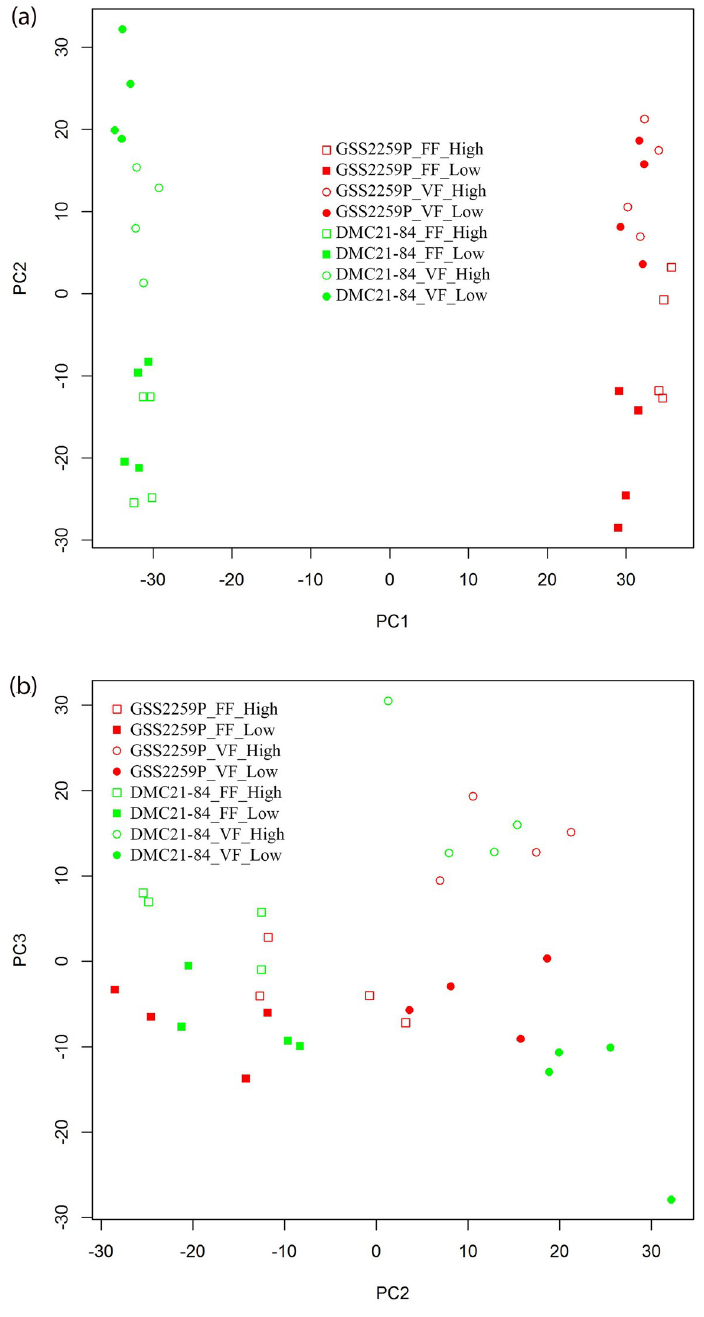
Fig 1. PCA plots with respect to a. PC1 and PC2, and b. PC2 and PC3. Treatments are identified by hybrid, site (FF = Fruit Farm; VF = Vegetable Farm), and plant density. homeostasis [48–51]. Due to the costly nitrogen requirement of HSP production, HSP produc- tion is poor under low nitrogen [52] or elevated CO [53]. A number of HSPs also were 2 involved in soybean response to weed competition [54]. The HSPs found in both hybrids including some other genes such as FK506 binding protein were also significant to crowding stress tolerance gene expression analysis among sweet corn hybrids [31].